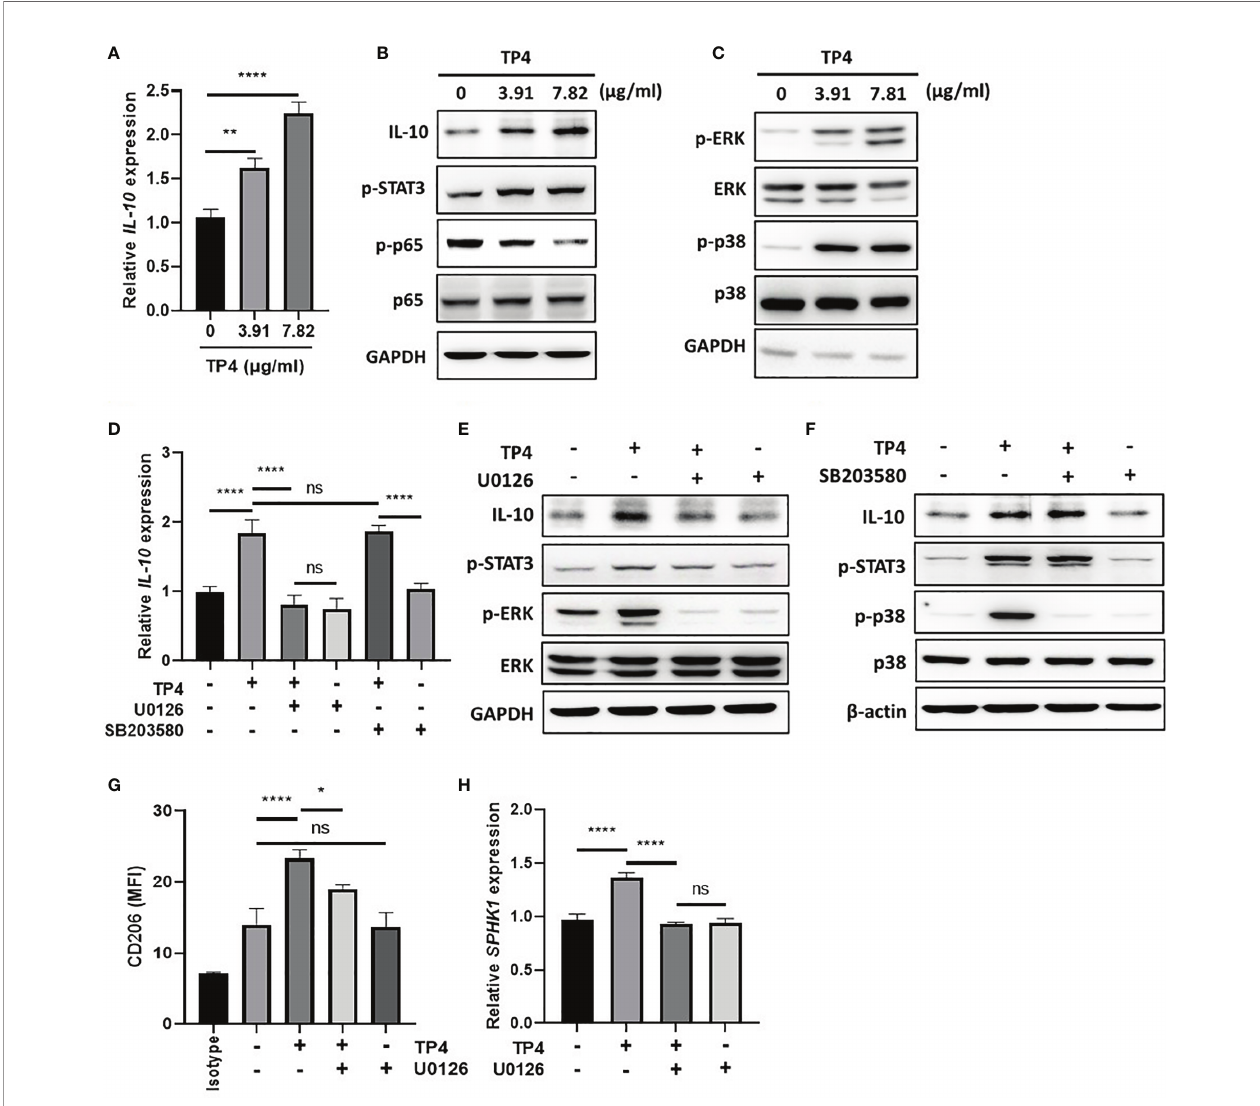
FIGURE 6 | TP4 induces IL-10 expression via MAPK/ERK pathway in THP-1/GV cells and promotes M2c phenotypes. (A) IL-10 expression was measured after 4 h TP4 (3.91 or 7.82 m g/ml) treatment of THP-1/GV cells by qRT-PCR. Data were represented the normalized target gene amount relative to the group of 0 m g/ml. (B) IL-10, and phosphorylated STAT3 (p-STAT3) and NF k B p65 subunit (p-p65) after 4 h TP4 (3.91 or 7.82 m g/ml) treatment of THP-1/GV cells were detected by immunoblotting. GAPDH was used as an internal control to show equal protein loading. (C) Detection of total and phosphorylated ERK (ERK/p-ERK) and p38 (p38/ p-p38) after 4 h TP4 (3.91 or 7.82 m g/ml) treatment of THP-1/GV cells by immunoblotting. GAPDH was used as an internal control to show equal protein loading. (D) THP-1/GV cells were pre-treated with ERK inhibitor (U0126; 10 m M) or p38 inhibitor (SB203580; 10 m M) for 2 h in the serum-free medium. After incubation,